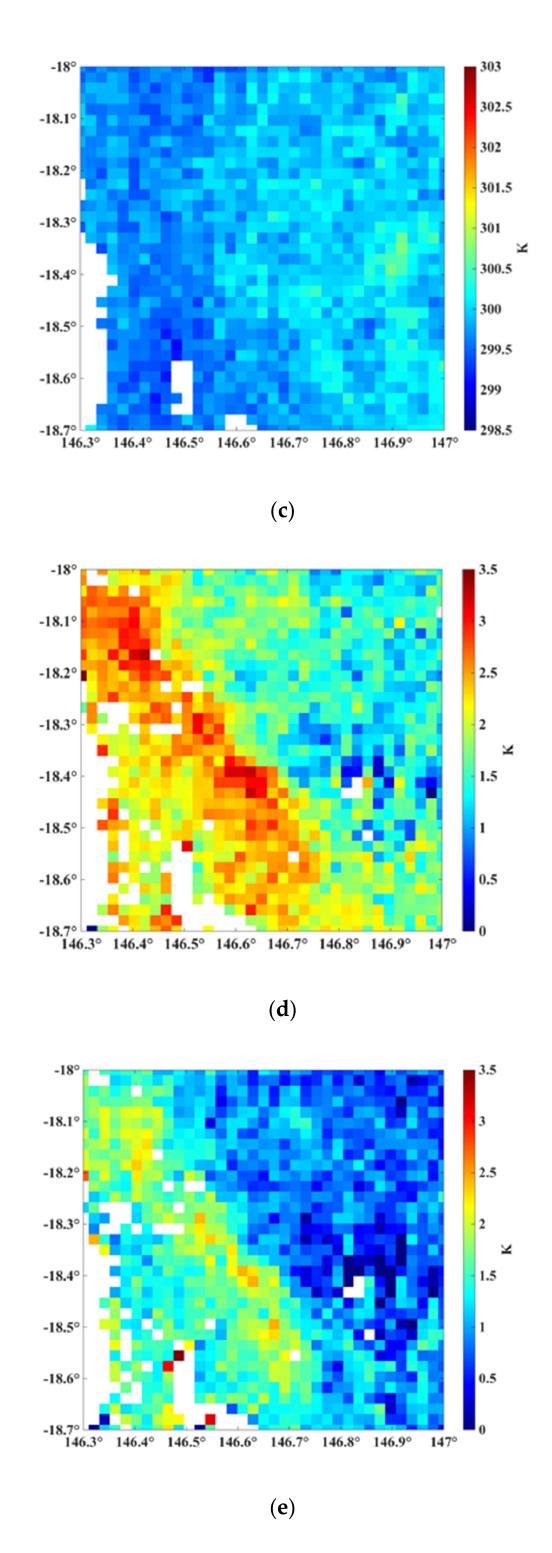
Figure 8. Images of Himawari-8 AHI skin SST during a diurnal warming event on 12 th October 2016: ( a ) 6 a.m.; ( b ) 12 p.m.; ( c ) 6 p.m.; ( d ) SST difference between 12 p.m. and 6 a.m.; ( e ) SST difference between 12 p.m. and 6 p.m.